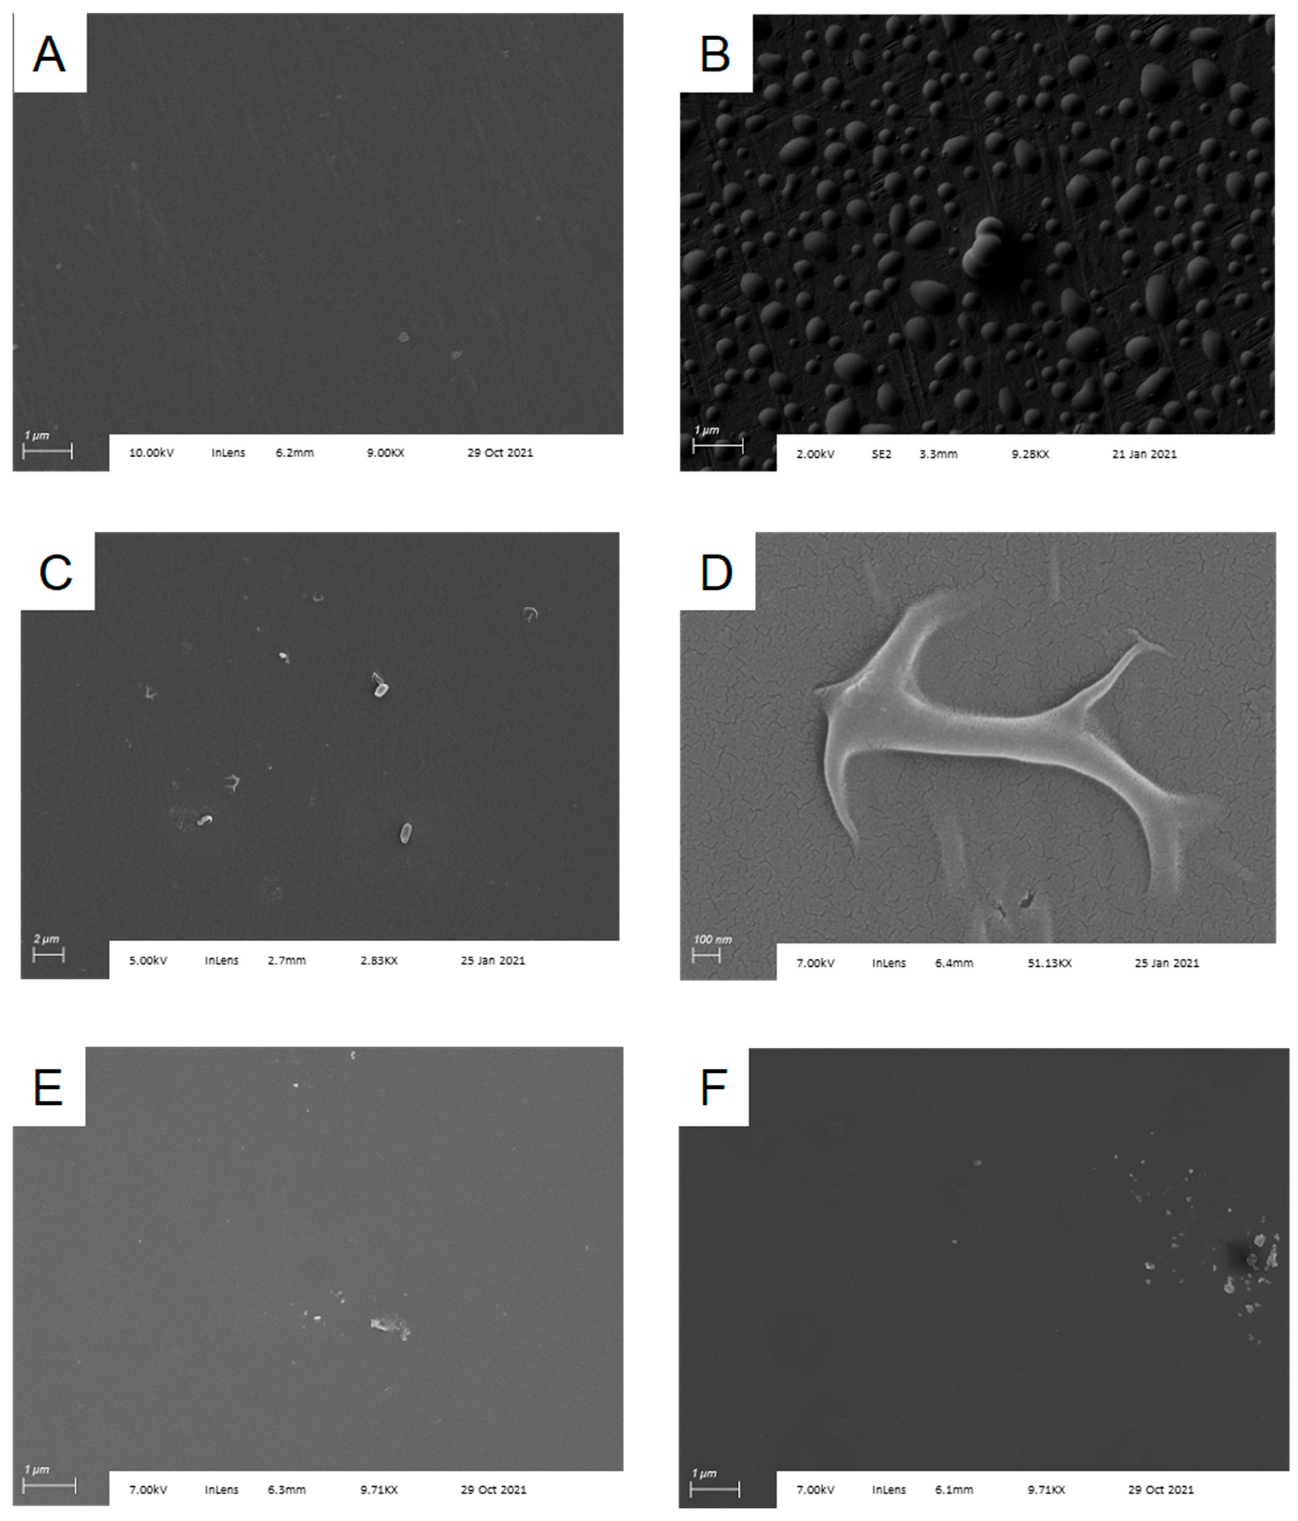
Figure 2. Silanization of Al/Al 2 O 3 substrates. ( A ) Cleaned substrate as obtained from the supplier; ( B ) substrate following silanization with TESP-SA; ( C ) substrate following silanization with APTES; ( D ) higher magnification image of silanization “fold” from ( C ); ( E ) Si/SiO 2 substrate following silanization with TESP-SA; ( F ) Si/SiO 2 substrate following silanization with APTES.